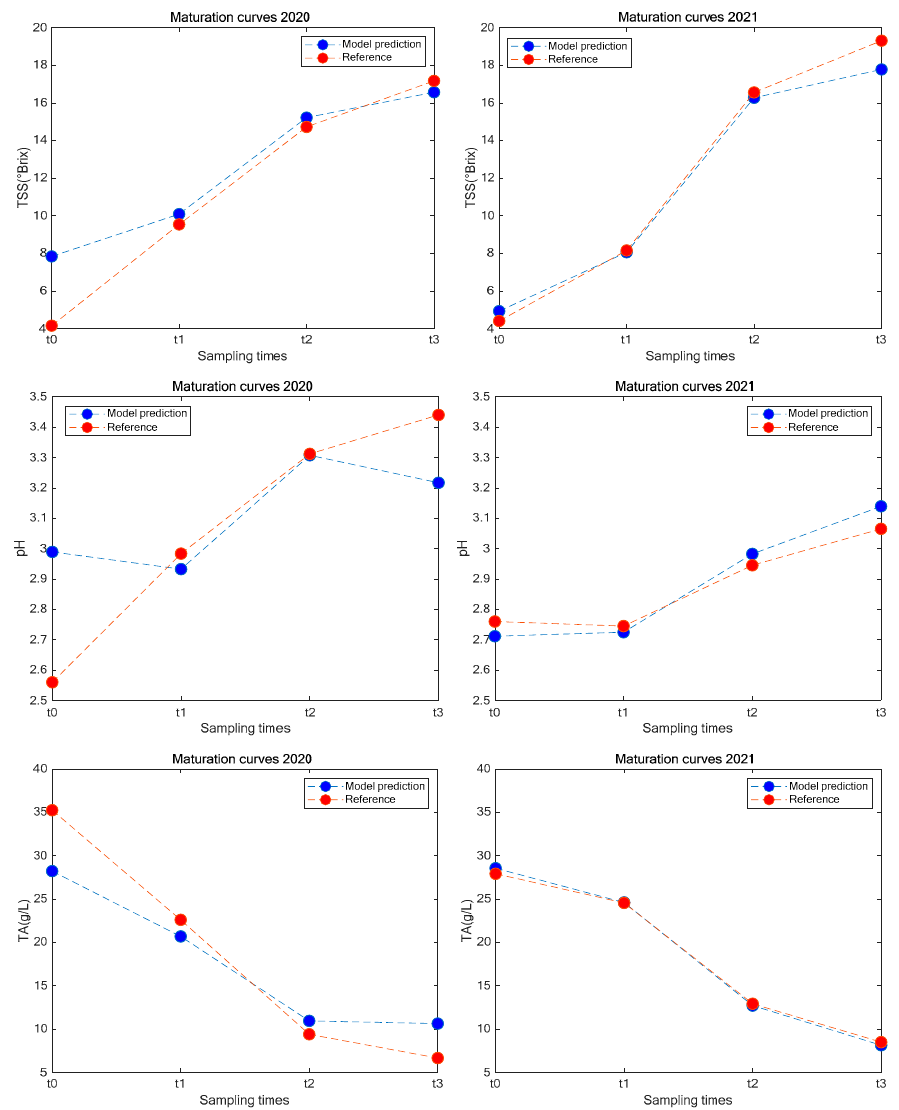
Figure 5. Maturation curves of the two harvest years (2020 and 2021) of the three qualitative parameters: in blue, the average values predicted by the models and in red, the average values measured by wet-chem analyses.